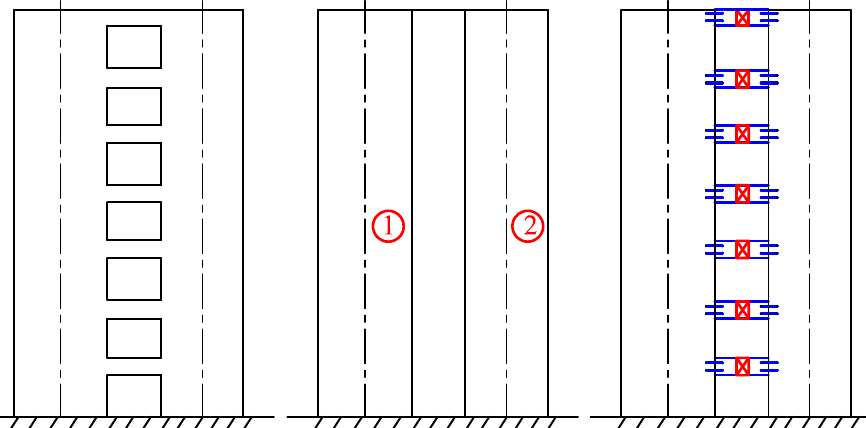
Figure 4. Construction of a coupled shear wall with energy dissipation device.